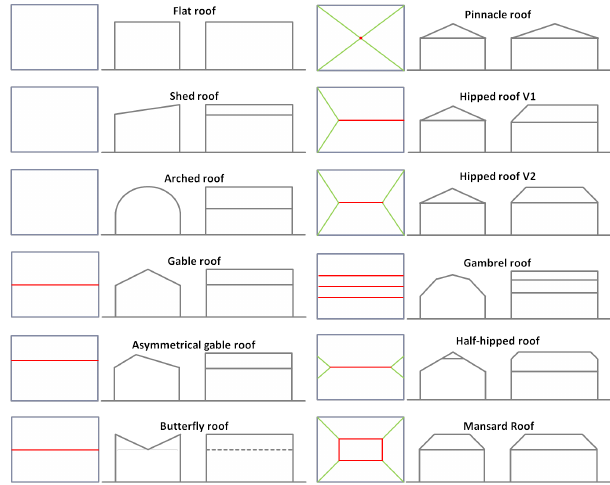
Figure 6. Predefined primitive